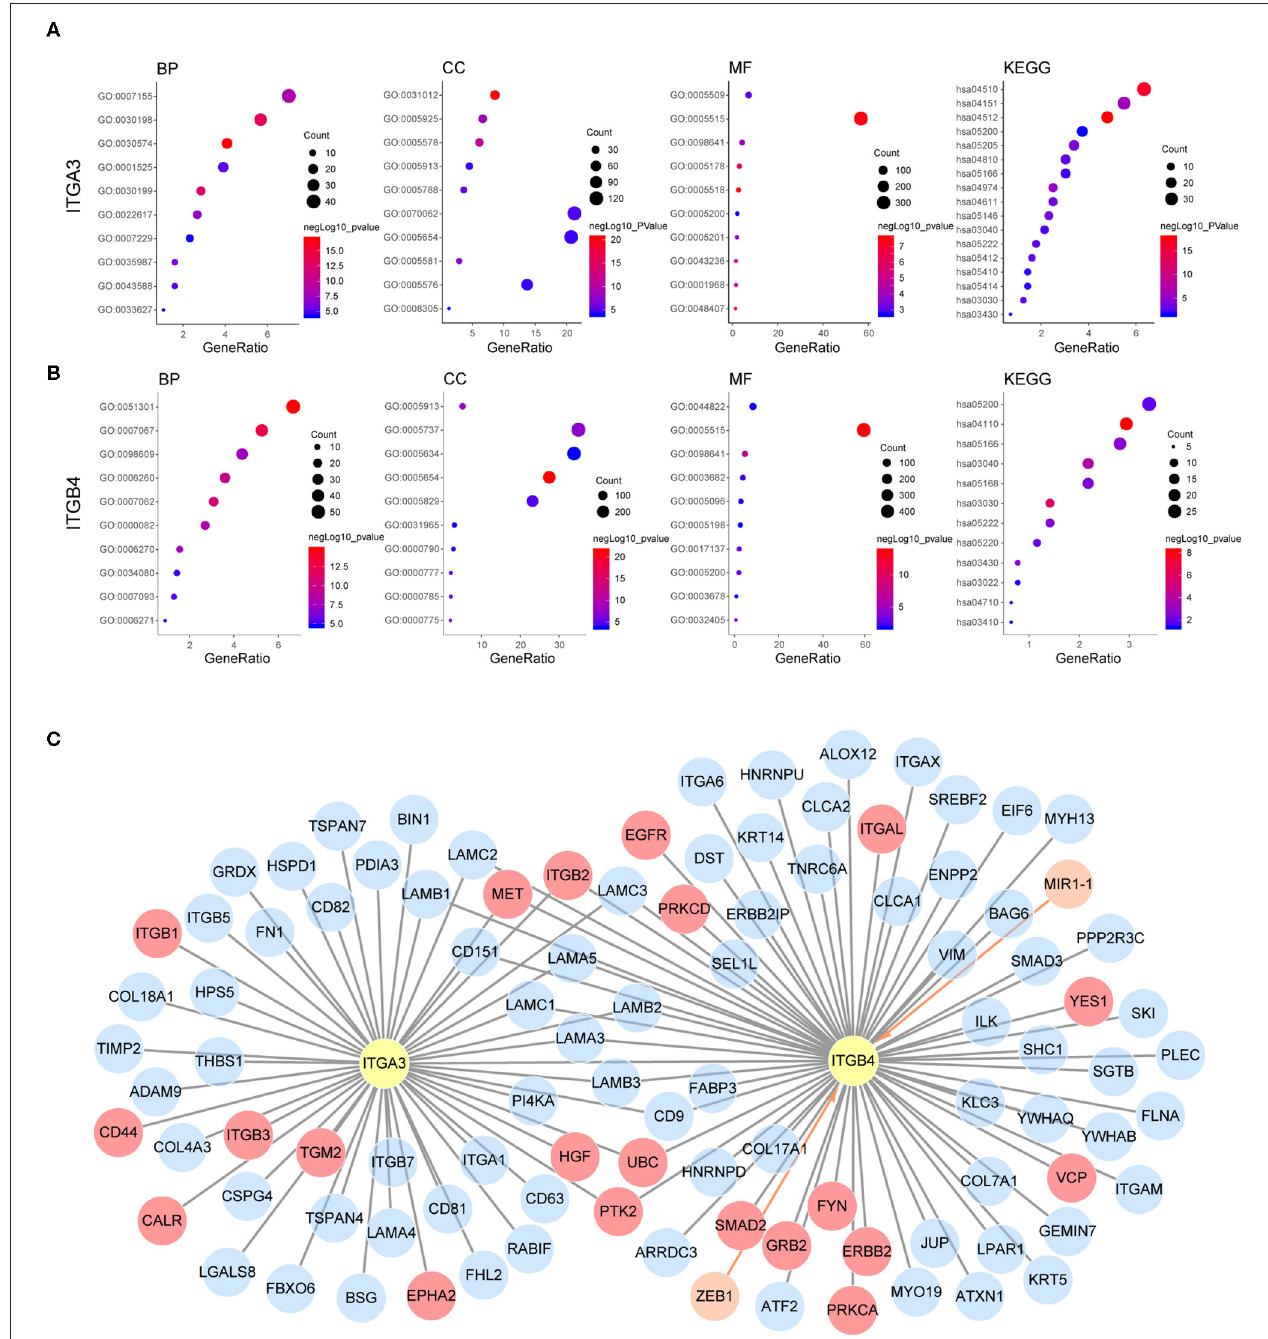
FIGURE 6 | Possible mechanism of ITGA3 and ITGB4 involved in OC. Top10 significantly enriched GO TERM and all significant enriched KEGG pathways for (A) ITGA3 and (B) ITGB4. (C) Regulatory network of ITGA3 and ITGB4, nodes in orange and edges with an arrow represents upstream transcriptional regulator, nodes with gray edges showed partners with physical protein interaction, gray edges with red nodes showed interaction partners with available drug basing on drugbank database.